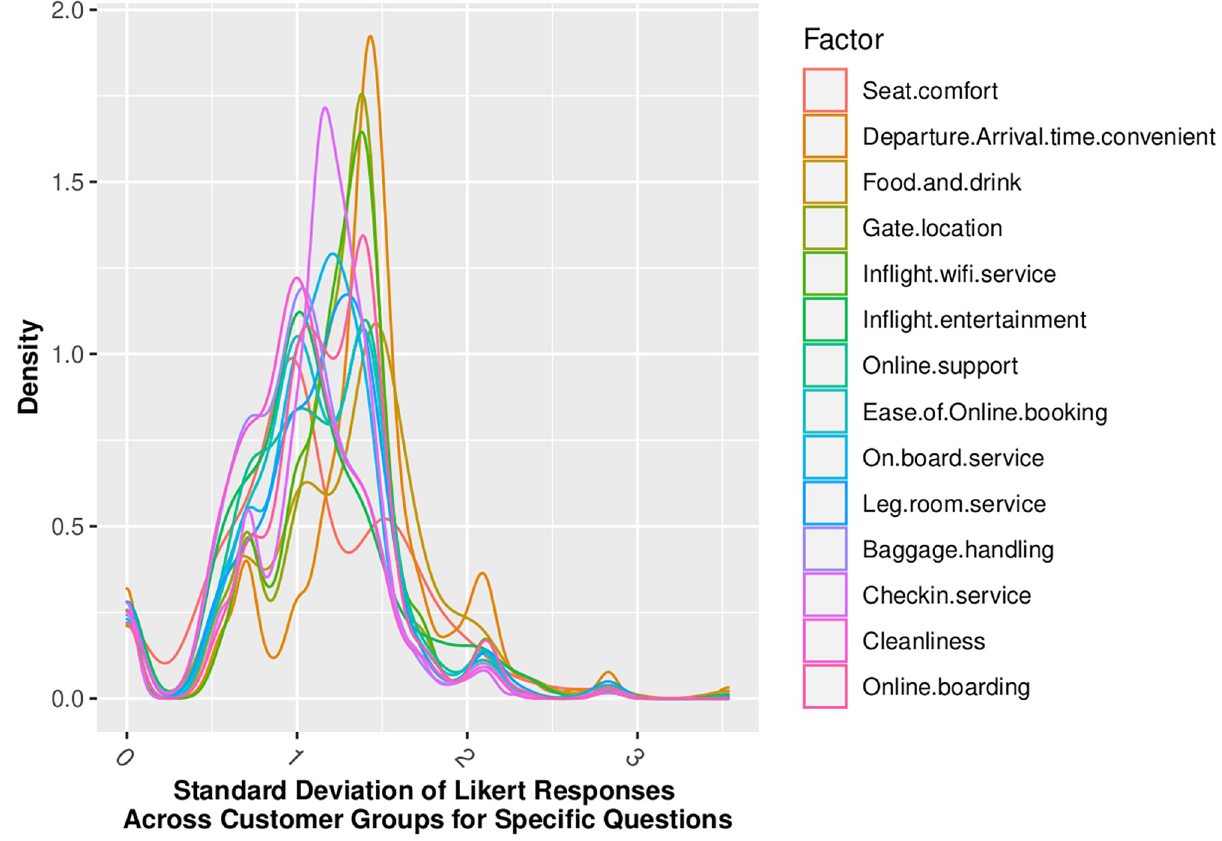
Fig 3. Standard deviation of likert responses by